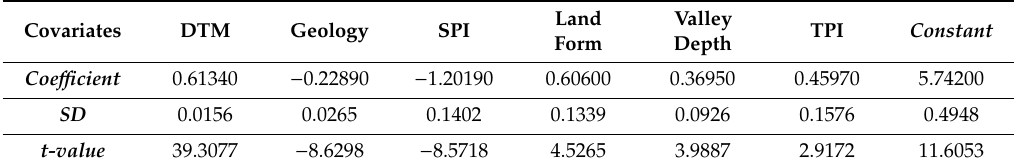
Table 3. Results of the coe ffi cients and t-value by eliminating insignificant covariates and small e ff ect parameters in the equation (estimation 3).